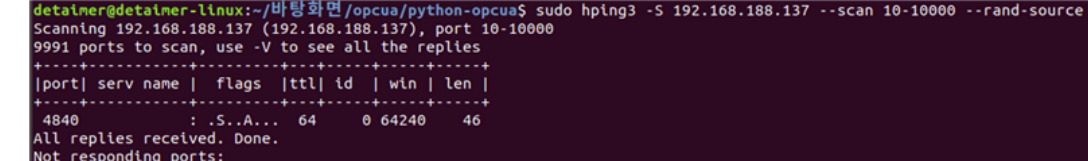
Figure 16. Attacker check open ports.